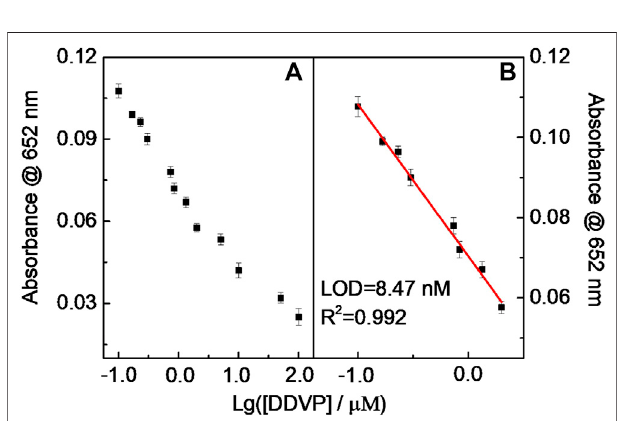
FIGURE 12 | Relationship curve (A) and the linear fi tting (B) between Abs at 652 nm and Lg (DDVP).